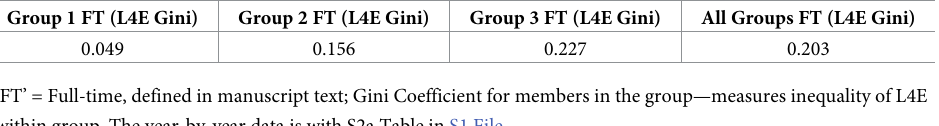
Table 2. Gini coefficient by year, full-time only (L4E workload).